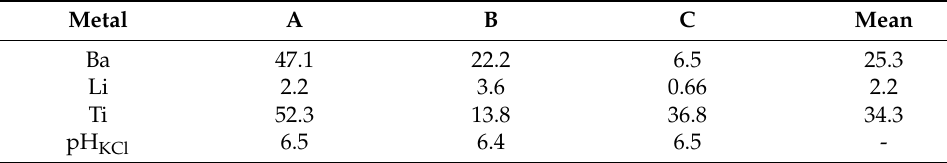
Table 4. Ba, Li and Ti concentration in bottom sediment (mg kg − 1 DM).